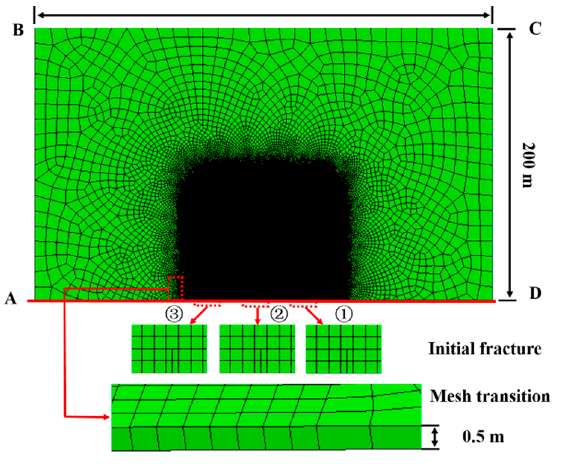
Figure 8. Construction of element model.